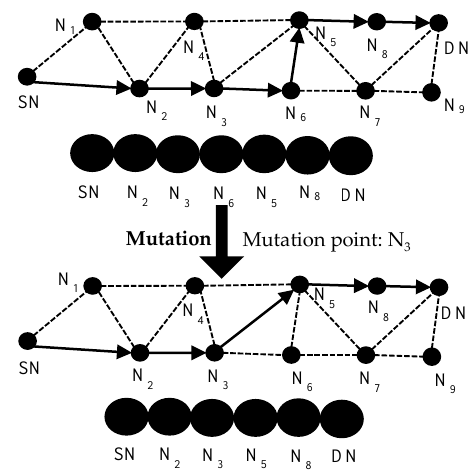
Figure 5. The mutation procedure.